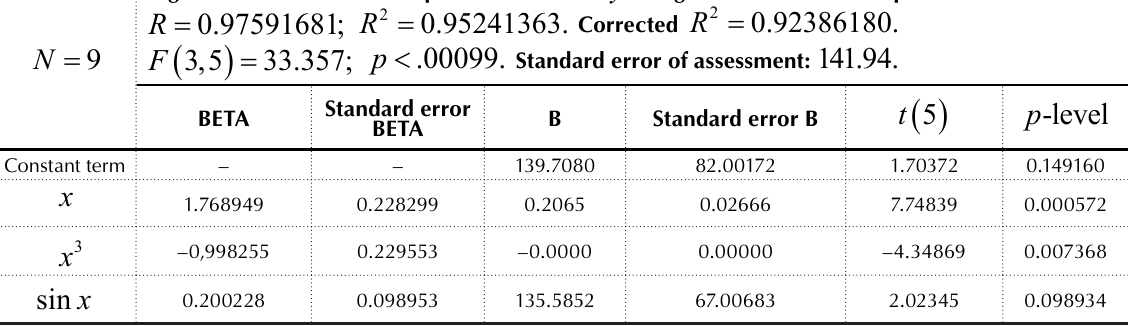
Table 2. The results of regression for the standard deviation of the size of the Deposit Guarantee Fund ( ) y from its volume ( ) x Regression results for the dependent variable: y (target function of the Deposit Guarantee Fund) 0.97591681; R = 9 N = = .00099. p < Standard error of assessment: 141.94. Standard error BETA